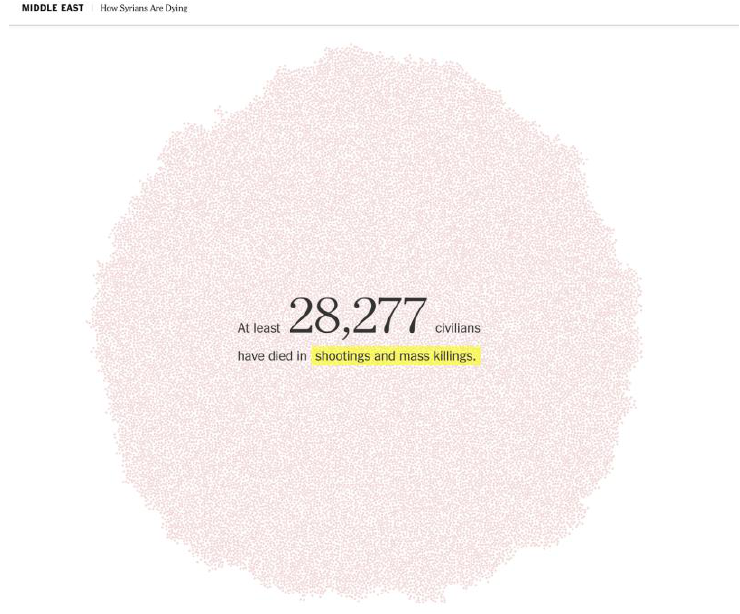
Figure 7. The dot-based visualization designed by the New York